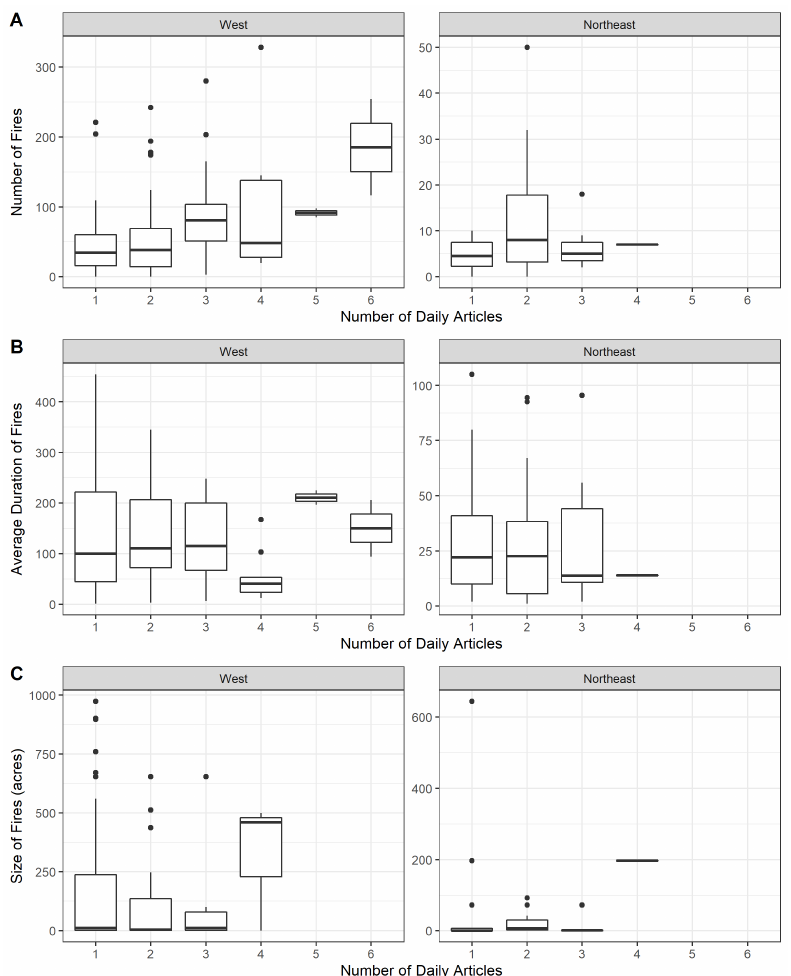
Figure A4. Associations between coverage and number ( A ), duration ( B ), and size ( C ) of fires. More articles are generally published in the west (than the northeast) when there are more fires or the fires last longer while the size of fires seems to have a threshold effect, with a lot more articles being published in both regions when the fires are at least 200